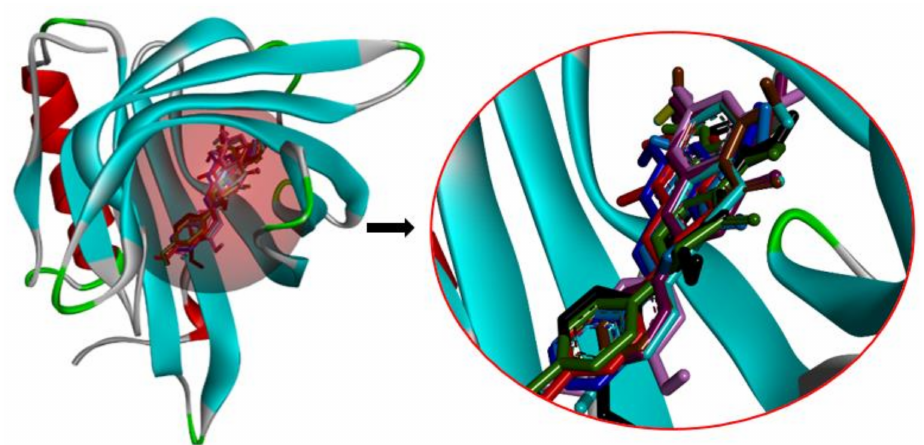
Figure 3. Binding positions of nine potential anti-T2DM Asian propolis compounds in Table 7 (RBP4) (PDB ID: 2WR6). The compounds are shown in various ligand colors; (color—number code of compound) red—21, blue—288, black—353, violet—359, light purple—482, tosca—482, brown—640, light blue—641, and dark green—681.